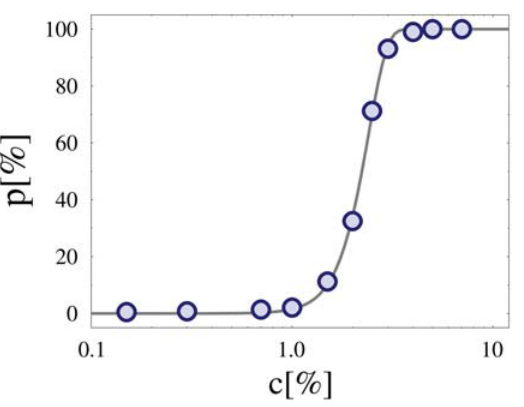
Figure 3. Equilibrium state as function of c . The equilibrium value of the fraction of paired chromosomes, p , is plotted as function of the concentration, c , of binding molecular factors, for a given value of their affinity, E (here, E =1.2 kT ). When the concentration is below a threshold value c * . 2.3%, no stable pairing is observed ( p , 0) and the chromosomes randomly float away from each other (‘Brownian phase’). Above threshold, p saturates to 100%, as a phase transition occurs (to the ‘Pairing phase’) and chromosomes spontaneously colocalize, their driving force being an effective attraction of thermodynamics origin.